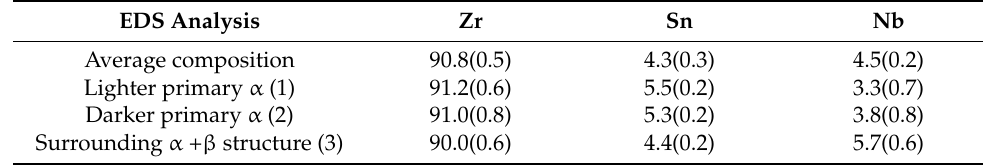
Table 4. EDS analysis of composition of particles found in forged + aged